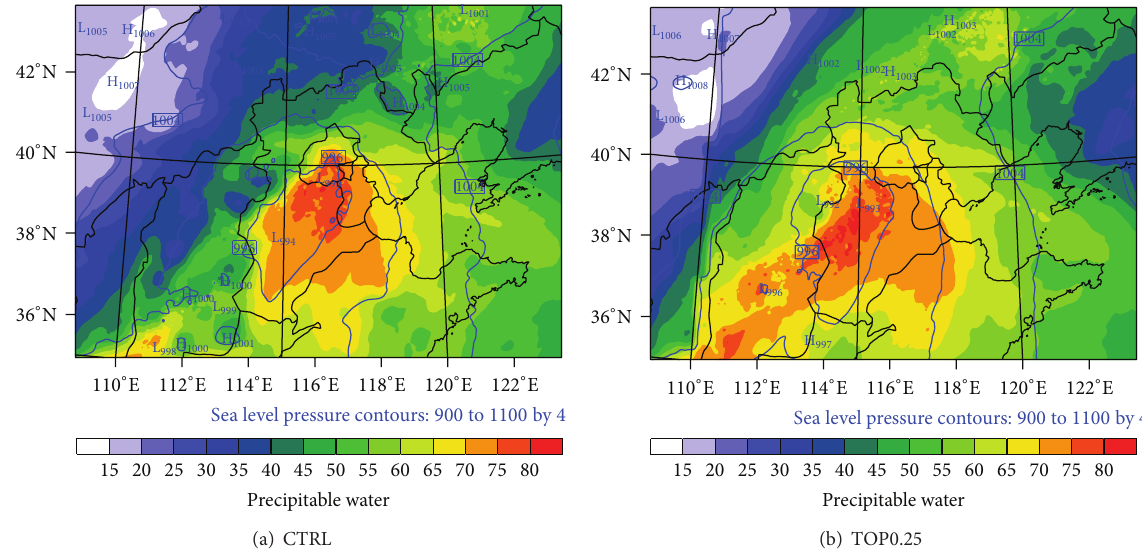
Figure 7: Modeled mean sea level pressure (contour, hPa) superposed with precipitable water (pw) (shaded, mm) for (a) CTRL, (b) TOP0.25 at 18 UTC 21 July 2012.